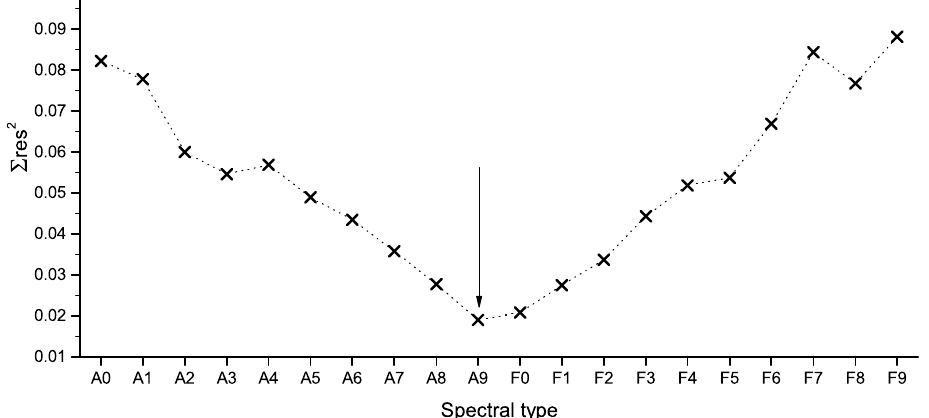
Figure 1. Spectral type-search plot for KIC 8504570. The arrow indicates the adopted spectral type for the primary component. The comparison is shown only between A0 and F9 spectral types due to scaling